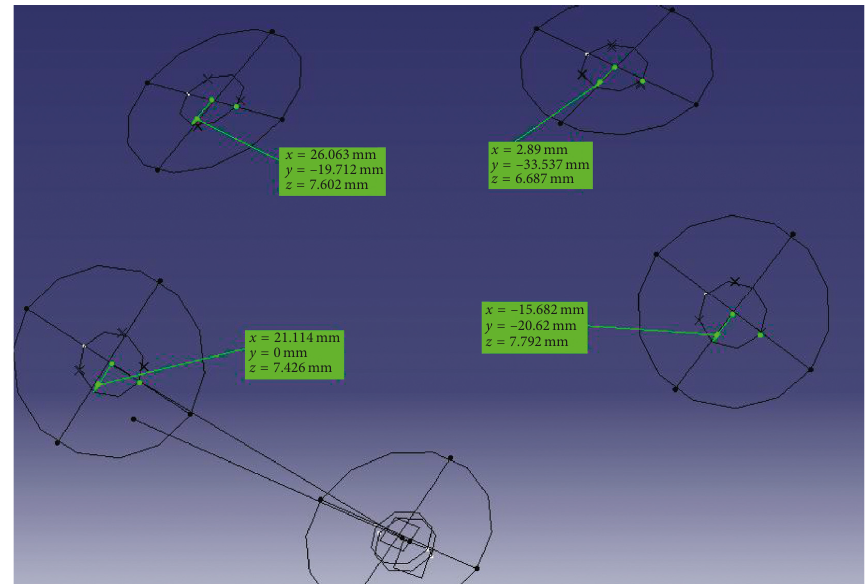
Figure 1: Schematic drawing of the measurements according to the reference